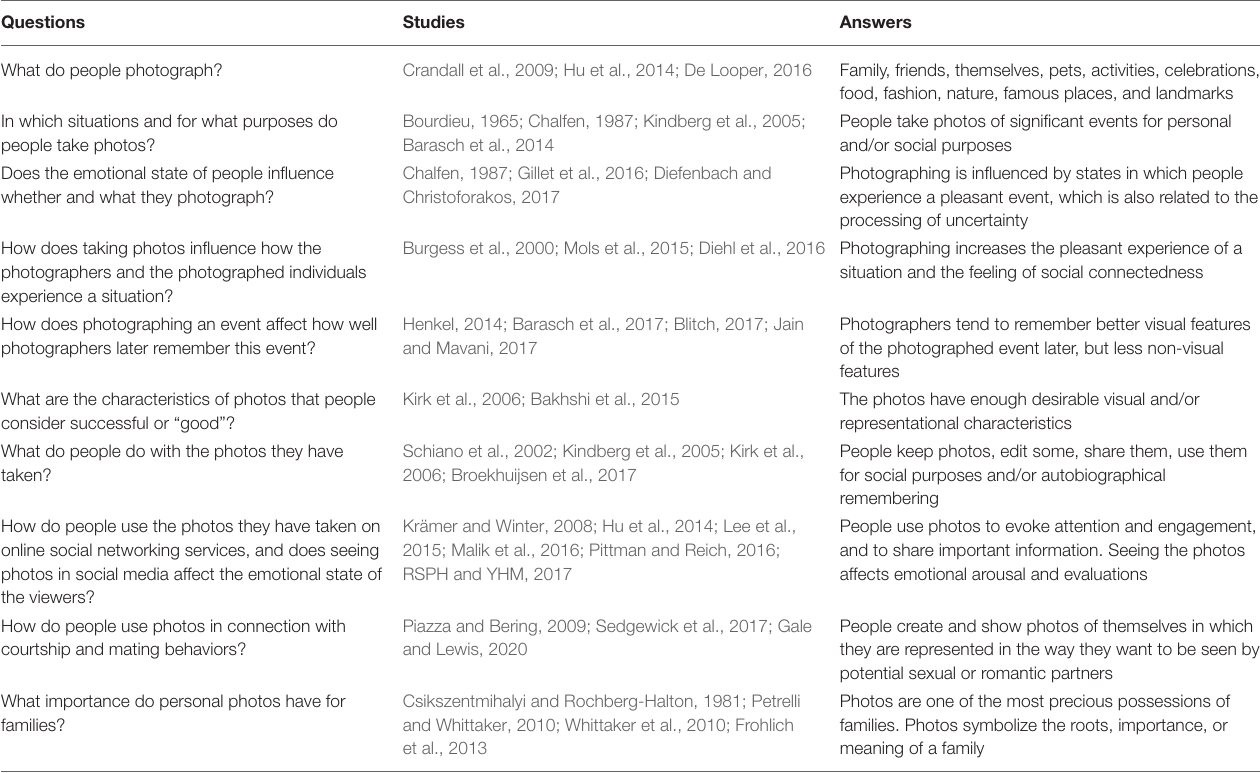
TABLE 1 | Questions and studies used to analyze the adaptative value of photography-related behaviors.